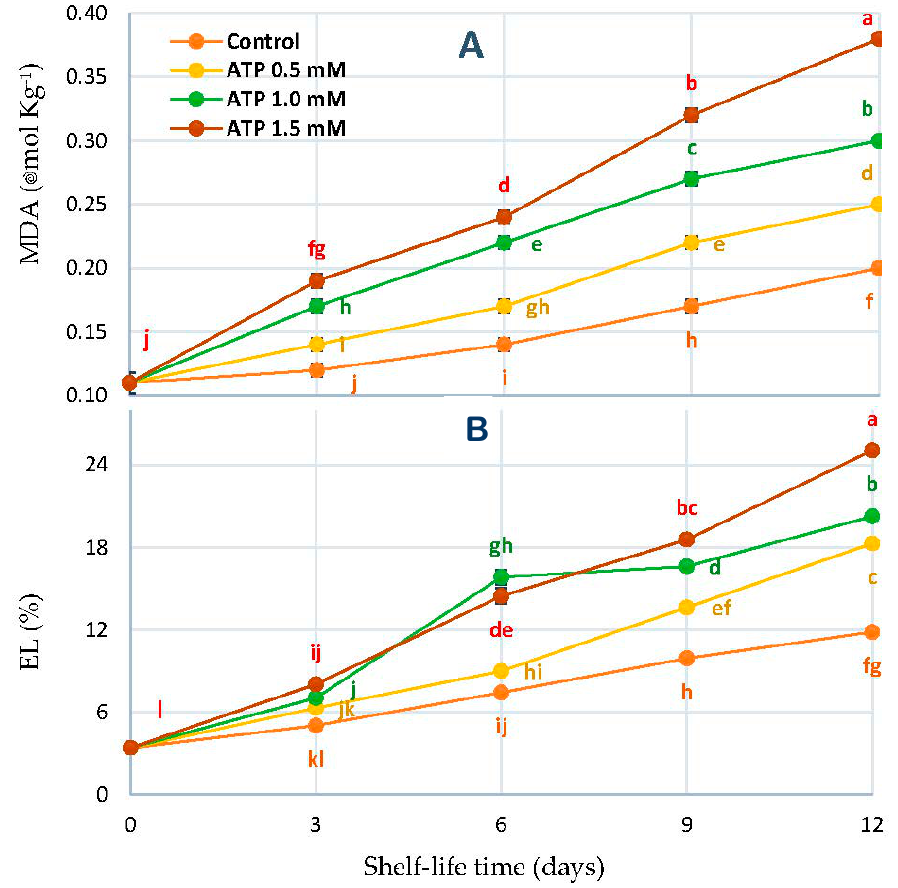
Figure 6. MDA ( A ) and EL% ( B ) of ‘Zaghloul’ date fruit treated with ATP at different concentrations (0, 0.5, 1.0, and 1.5 mmol L − 1 ) during storage at 27 ± 1 °C, 67 ± 3% R, for 12 d. Each value represents mean ± SE ( n = 3). The letters differ ( p < 0.05) and represent the significance between treatments using the Tukey–Kramer HSD test to compare the different treatments.